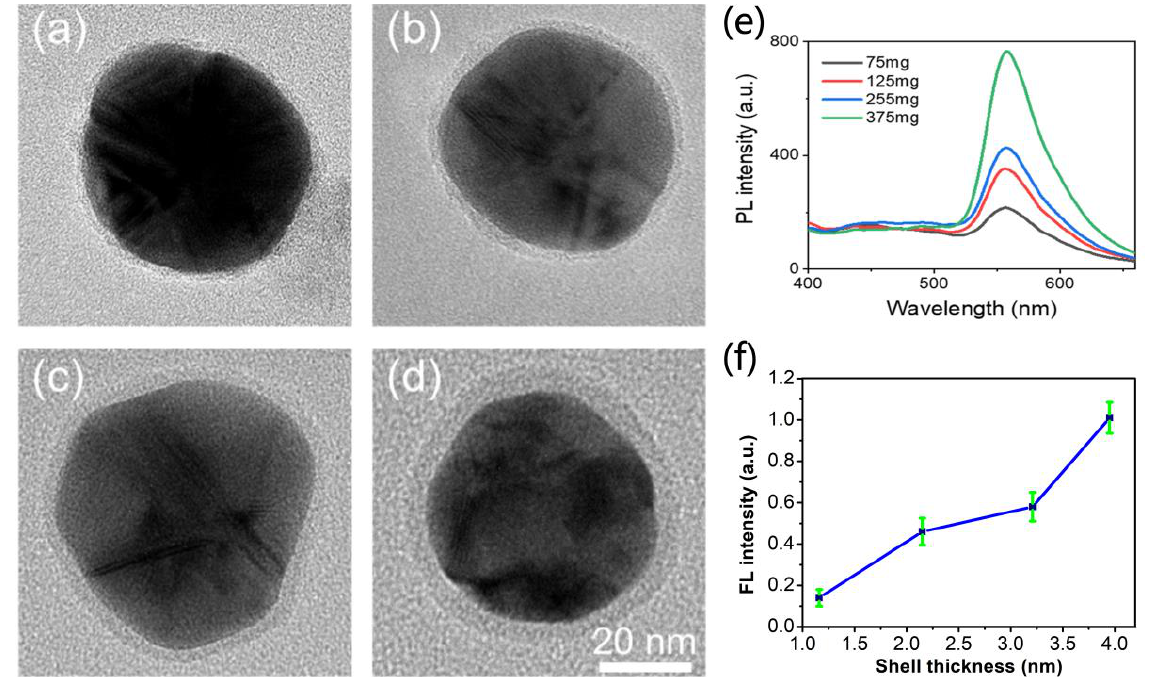
Figure 4. Effect of amount of QC in reaction mixture on shell thickness and fluorescence intensity of Ag@QCNPs. TEM images of Ag@QCNPs prepared using different amounts of QC ( a ) 75 mg, ( b ) 125 mg, ( c ) 255 mg and ( d ) 375 mg; ( e ) Relationship between amount of QC and fluorescence intensity of Ag@QCNPs; ( f ) Relationship between shell thickness and fluorescence intensity of Ag@QCNPs.